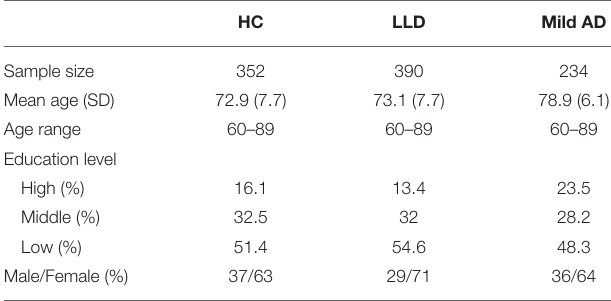
TABLE 1 | Demographic characteristics of the